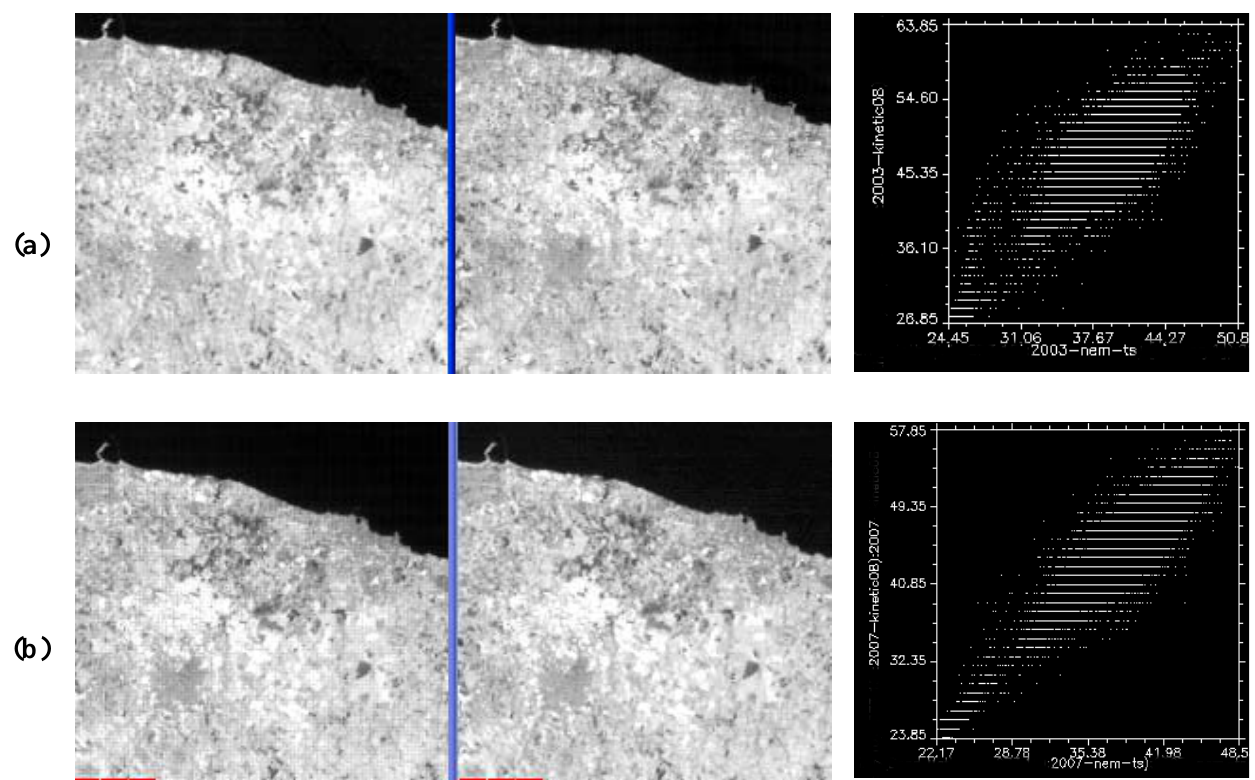
Figure 2. NEM processed ASTER data (left), the on-demand Level-2 standard product AST-08 (centre) of (a) 24 June 2003 and (b) 14 July 2007 and the scatter plots showing their correlation